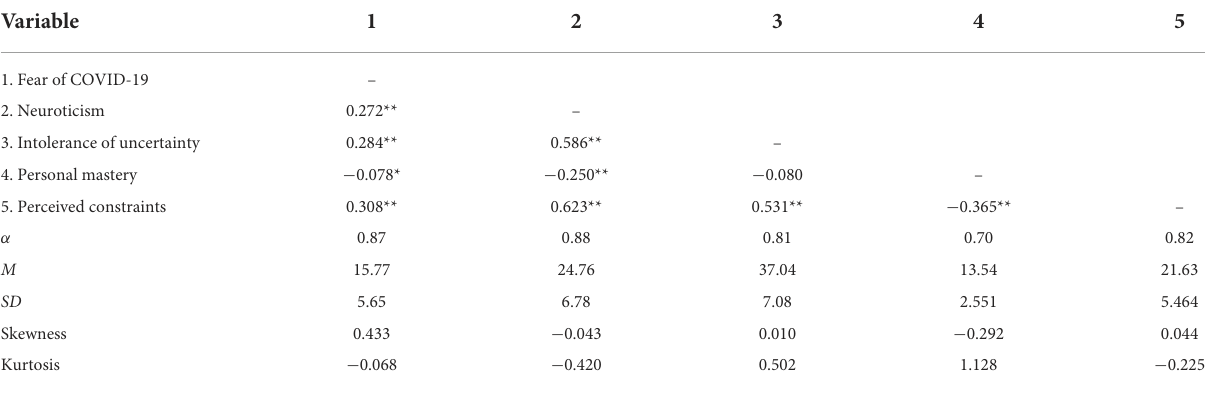
TABLE 2 Descriptive statistics and correlations among study